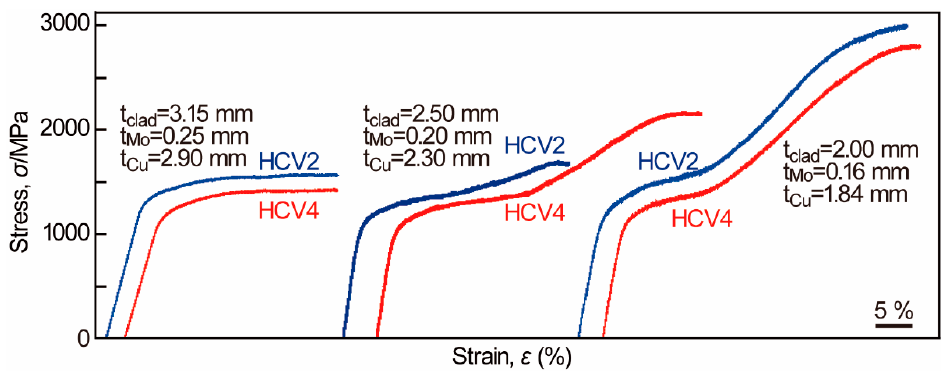
Figure 7. Bending stress–strain curves of HCV2 and HCV4 specimens at room temperature and 0.5 mm/m cross-head speed for three clad thicknesses of 3.15, 2.50 and 2.00 mm, keeping the ratio of Mo- and Cu-plate thickness the same as possible.